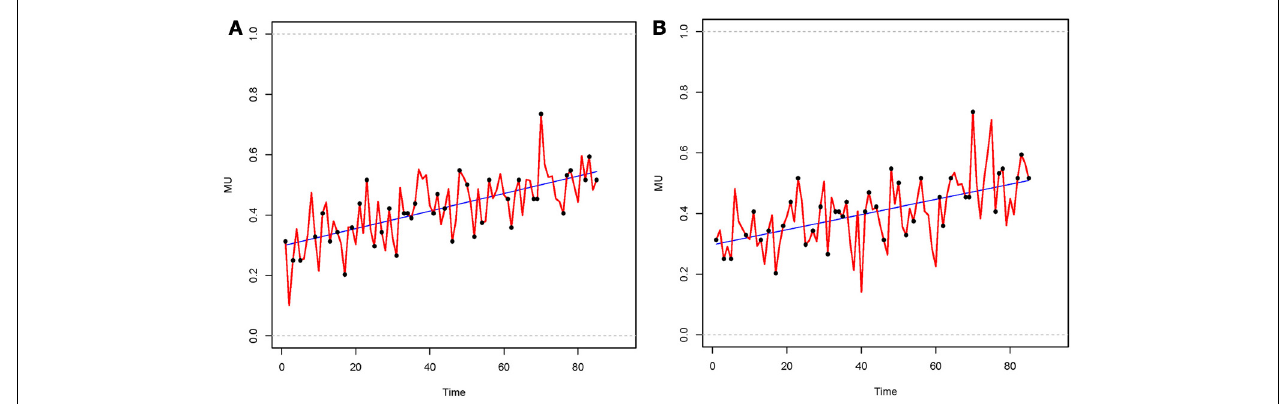
FIGURE 3 | B-spline imputed data of the same individual. Black dots on the curve denote the observed data, while pieces between were imputed. (A) Number of knots K = 5; (B) Number of knots K = 10.